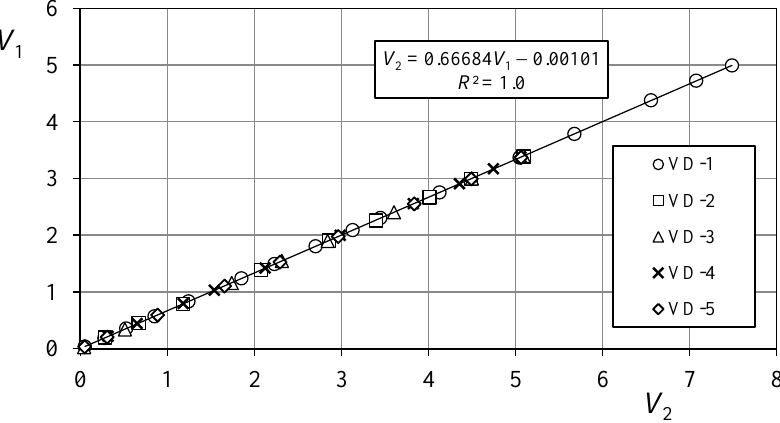
Figure 3. Transfer function (Equation (2)) of ABDAS voltage dividers. The Equation (linear fitting) correspondent to Channel-1 voltage divider (VD-1) is included in the Figure. See also Table 2. Table 2. Transfer function coefficients, a and b , of the voltage divider installed at each ABDAS input channel. The coefficient of determination, R 2 , corresponding to the fitting (see Figure 3) are included, together with the maximum and averaged error, | ε | max and | ε | avg , between the measurements (Figure 3) and the transfer function.